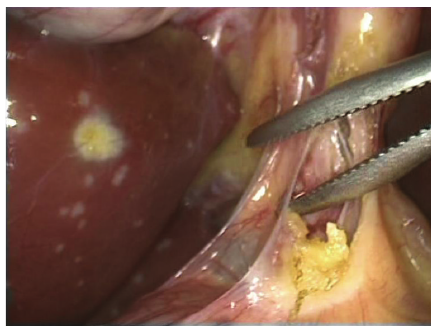
Figure 1: White plaques on the liver, noted during laparoscopy.